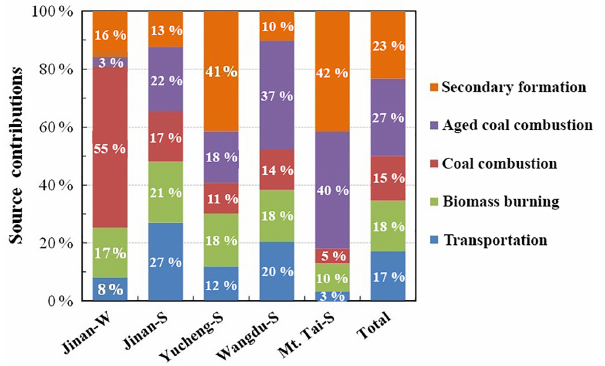
Figure 4. Contributions of the five source factors to the concentra- tions of particulate nitrated phenols at four sampling sites in winter- time and summertime. Total represents the average contributions of the five field measurements.